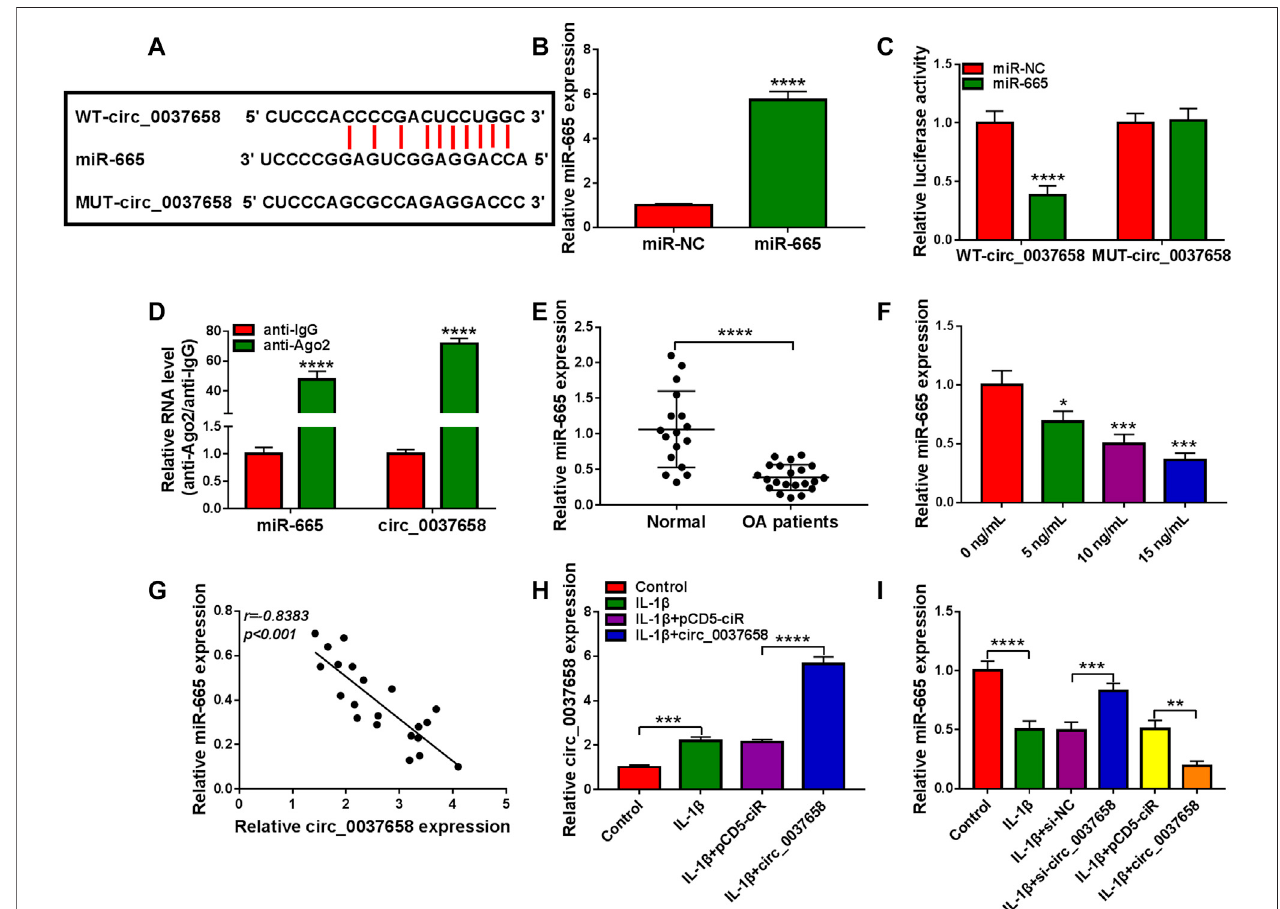
FIGURE3| Circ_0037658functionedasanef fi cientmiR-665sponge. (A) Thepredictedbindingsitesbetweencirc_0037658andmiR-665. (B) RT-qPCRanalysis of miR-665 expression (**** indicates p < 0.0001 relative to the miR-NC group). (C) A dual-luciferase reporter assay was utilized to assess binding (**** indicates p < 0.0001 relative to the miR-NC group). (D) RIP assay was performed in CHON-001 cell extracts to analyze miR-665 endogenously correlated with circ_0037658 (**** indicates p < 0.0001 relative to the anti-IgG group). (E) miR-665 level was measured in 21 OA cartilage tissues and 17 healthy cartilage tissues (**** indicates p < 0.0001relativetothecontrolgroup). (F) IL-1 β (0,5,10or15 ng/mlIL-1 β )onmiR-665 expression wasdeterminedusingRT-qPCRassay(**,***or****indicates p < 0.01, p < 0.001, or p < 0.0001 relative to the 0 ng/ml IL-1 β group). (G) Pearson correlation analysis was utilized to analyze the expression correlation